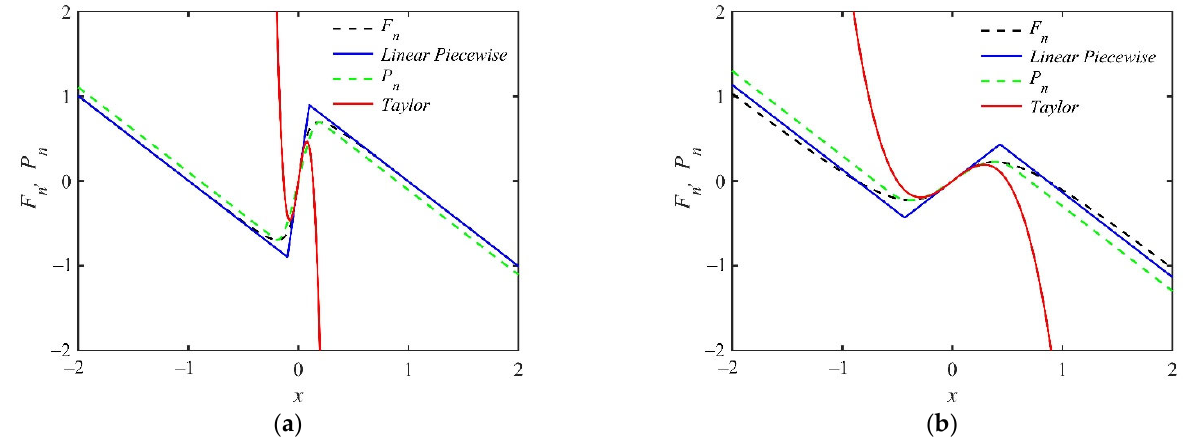
F , P , a linear piecewise function, and a three ‐ order Taylor series equiv ‐ Figure 3. The results of n n Figure 3. The results of F n , P n , a linear piecewise function, and a three-order Taylor series equivalent alent function ( a ) 0.1  ; ( b ) 0.5  . function ( a ) α = 0.1; ( b ) α =